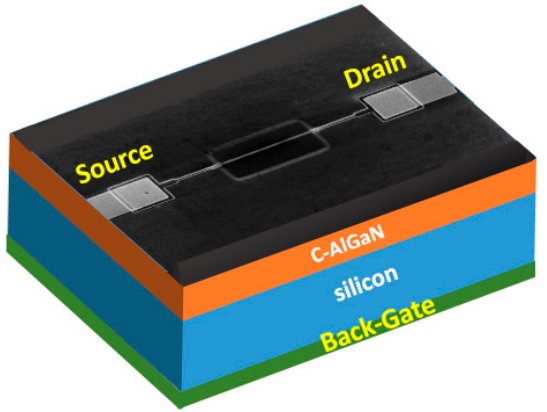
Figure 1. Fabricated TiO 2 /GaN nanowire field-effect transistor (FET) sensor. FESEM image of the two terminals. The TiO 2 /GaN device is shown on the top side.